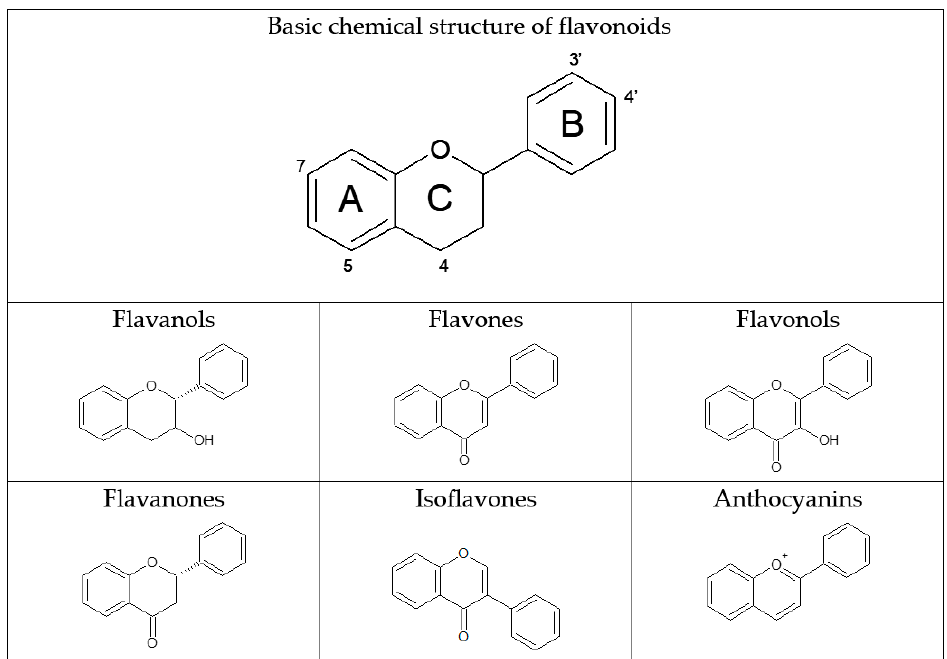
Figure 1. Chemical structures of flavonoids and their classes. Based on reference [1]. Flavonoids comprise more than 4000 compounds that are widely distributed in seeds, leaves, bark, and flowers of plants. Flavanols, as those found in green tea and cocoa, include monomers such as epicatechin, catechin, gallocatechin, epigallocatechin (EGC), and epigallocatechin gallate (EGCG) and, also, polymers called proanthocyanidins or condensed tannins. Flavones are commonly found in fruit skins, parsley, and celery and include glycosides of luteolin, chrysin, and apigenin. Flavonols can be found in onions, apples, berries, leeks, broccoli, blueberries, red wine, and tea and include, among others, quercetin, kaempferol, morin, rutin, myricetin, isorhamnetin, and isoquercetin. Flavanones are exclusive to citrus fruits and can be hesperidin, naringenin, and eriodictyol. Leguminous plants such as soy and soy products contain isoflavones such as genistein and daidzein. Finally, anthocyanins are provided by red wine and berry fruits, such as cherries, strawberries, raspberries, barberries, blueberries, and raisins, and include pelargonidin, cyanidin, and malvidin [1,2].